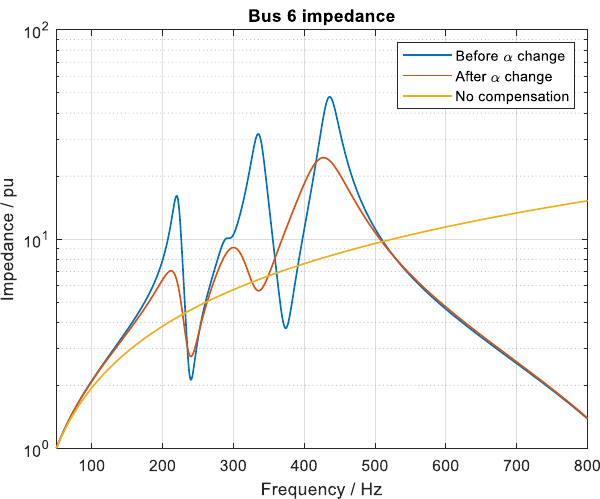
Figure 13. The 7th harmonic frequency parallel resonance mitigation in bus 6.